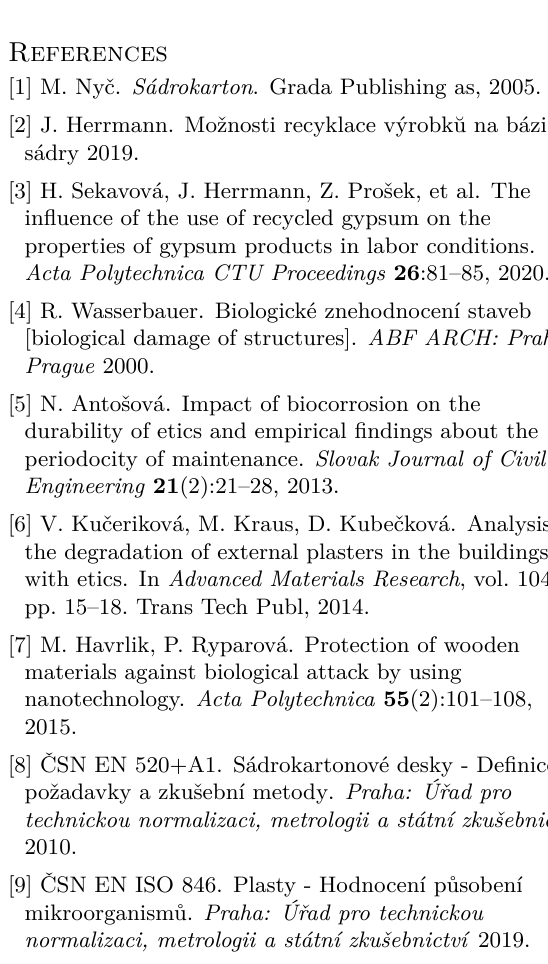
Figure 8. Sample 8 (left) and sample 9 (right) after 11